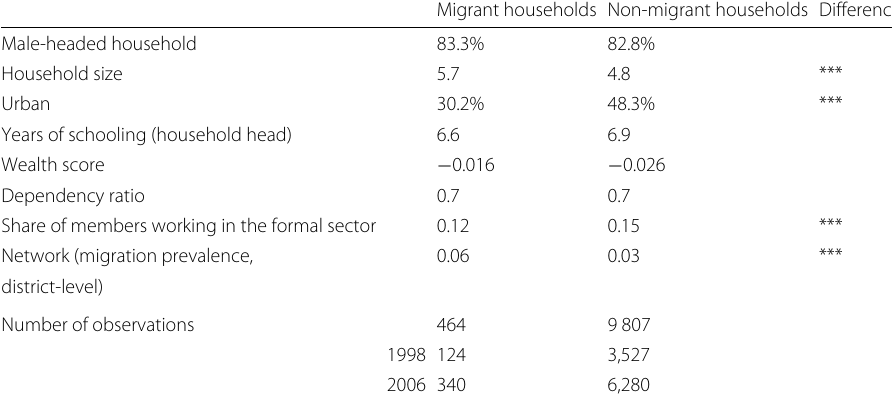
Table 1 Descriptive statistics at the household level (sample I) Migrant households Non-migrant households